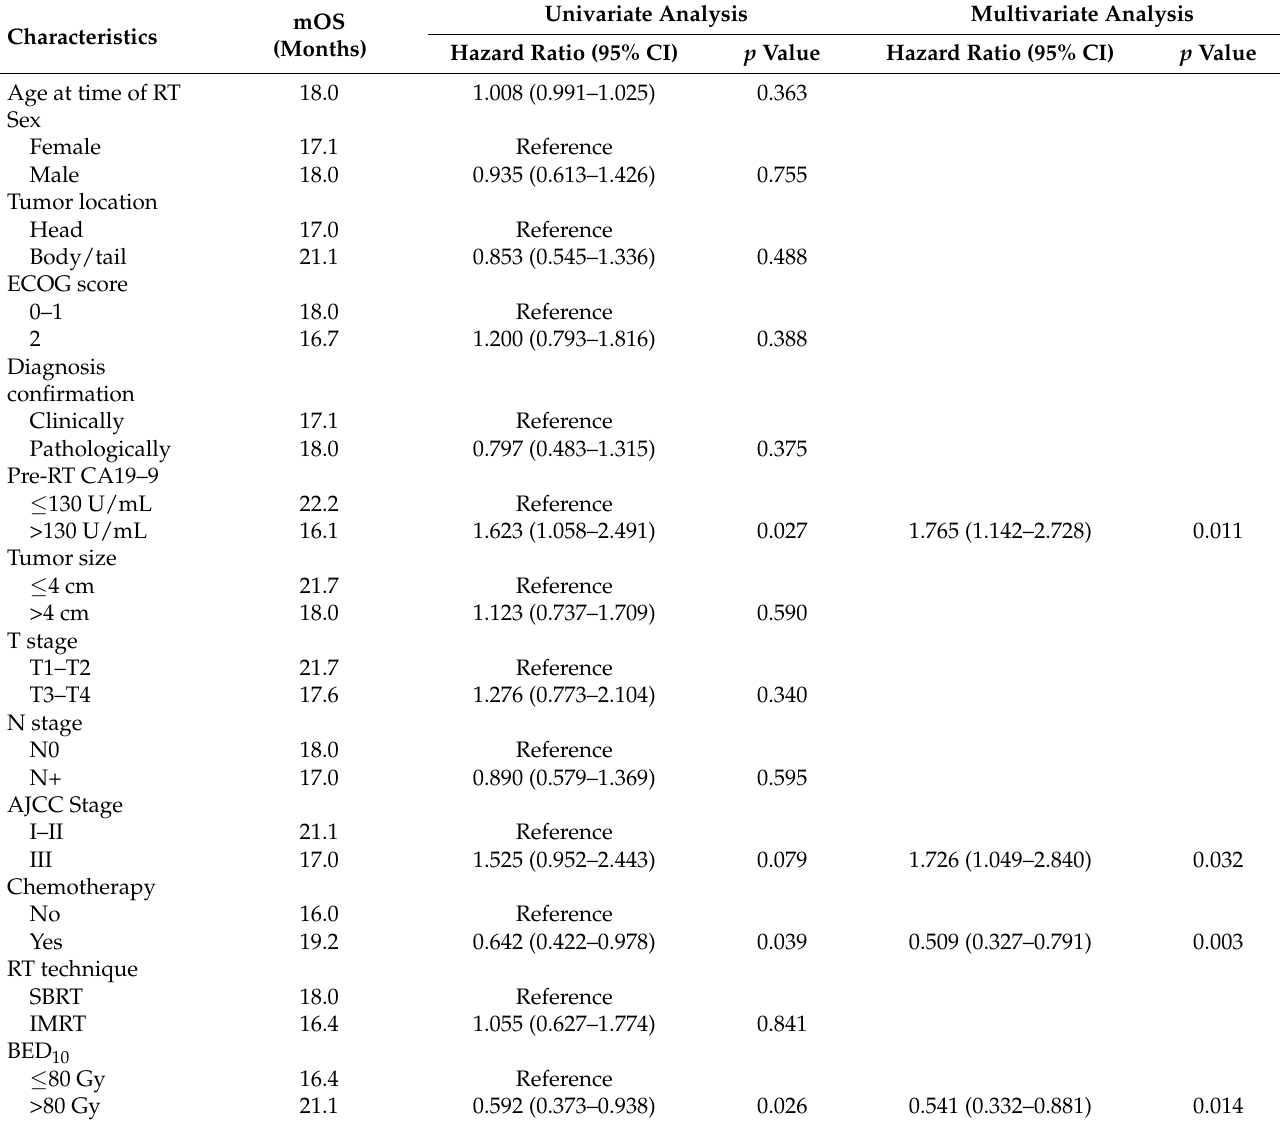
Table 2. Univariate and multivariate analyses for overall survival from